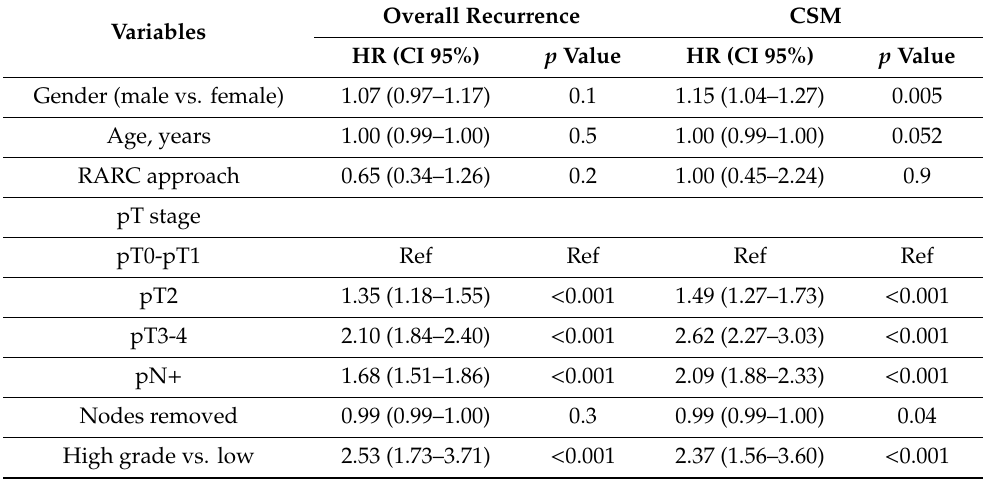
Figure 1. Cumulative incidence of recurrence and cancer specific mortality on overall population of patients with non-metastatic bladder cancer (BCa) treated with radical cystectomy according the type of surgery (ORC vs. RARC). Table 3. Multivariable competing risk analyses predicting the risk of overall recurrence and cancer specific mortality (CSM) in patients treated with radical cystectomy in overall patients.